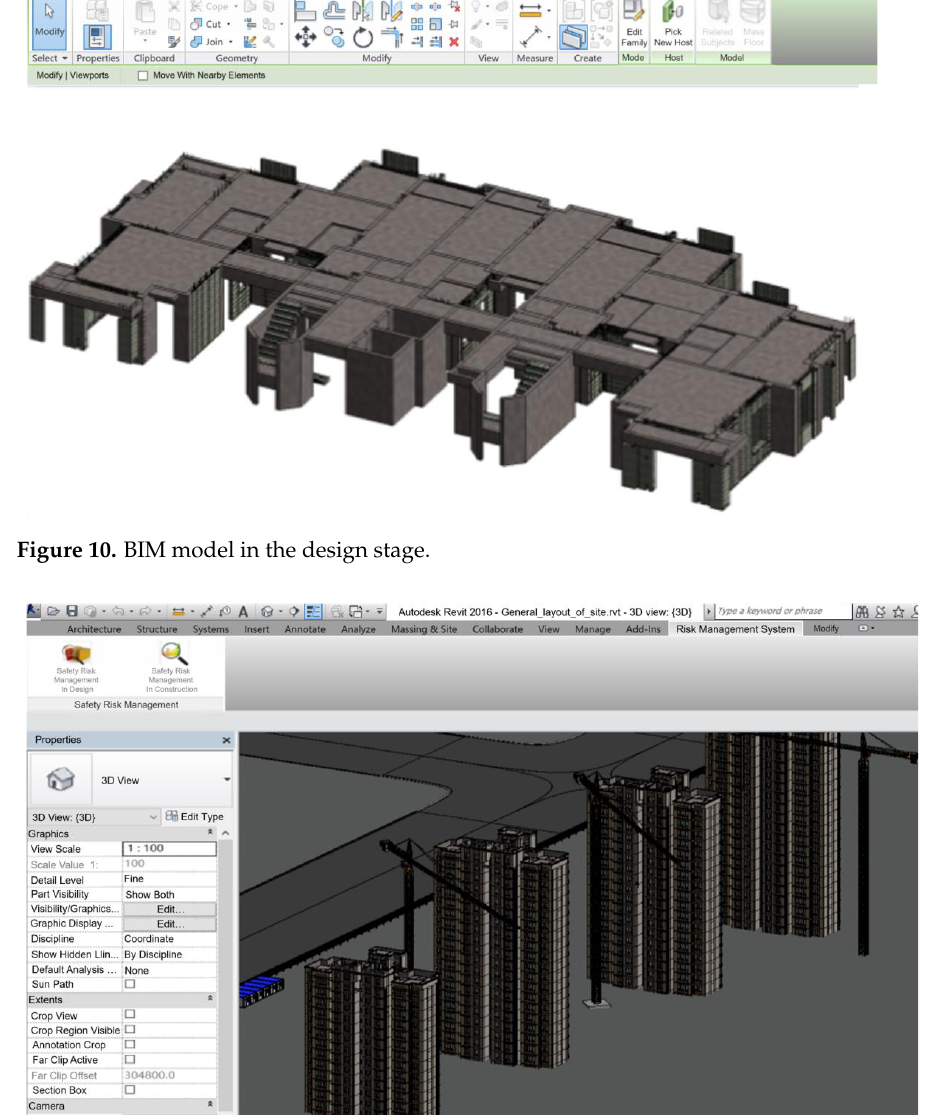
Figure 12. IFC file export process. After this exporting step, the IFC documents exported from the design model were scanned by the developed detection algorithm. The express language from the IFC docu- ment was detected through Java language analysis and automatically mapped to the OWL language. Then, relevant parameters were extracted and transformed into a recognizable ontology format to form ontology instances and corresponding attribute values. The re- sults obtained in the ontology software are shown in Figure 13. In the figure, the data attribute values for different component examples are indicated with a red box. “ YZJLQ- 03 ” , for example, represents the precast shear wall, and its data attribute is represented by “ has _ the _ size _ of _ hole ” 2200 * 1600 ” ^^ xsd: string ” , and so on.